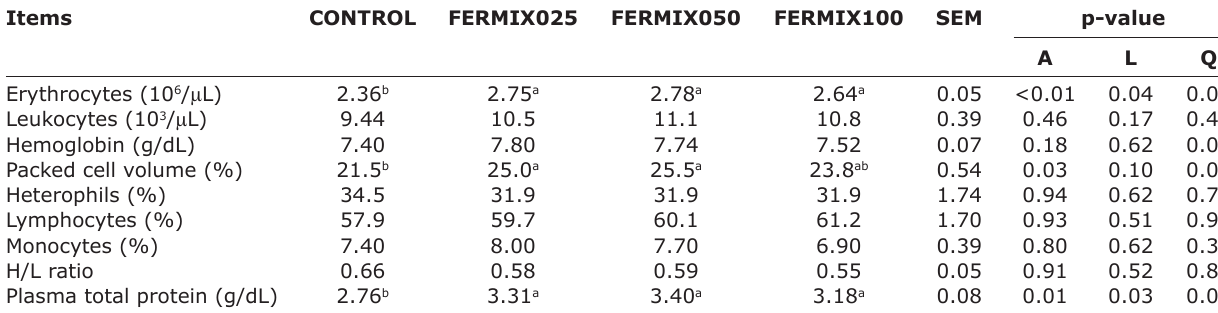
Table-5: Blood parameters of broiler